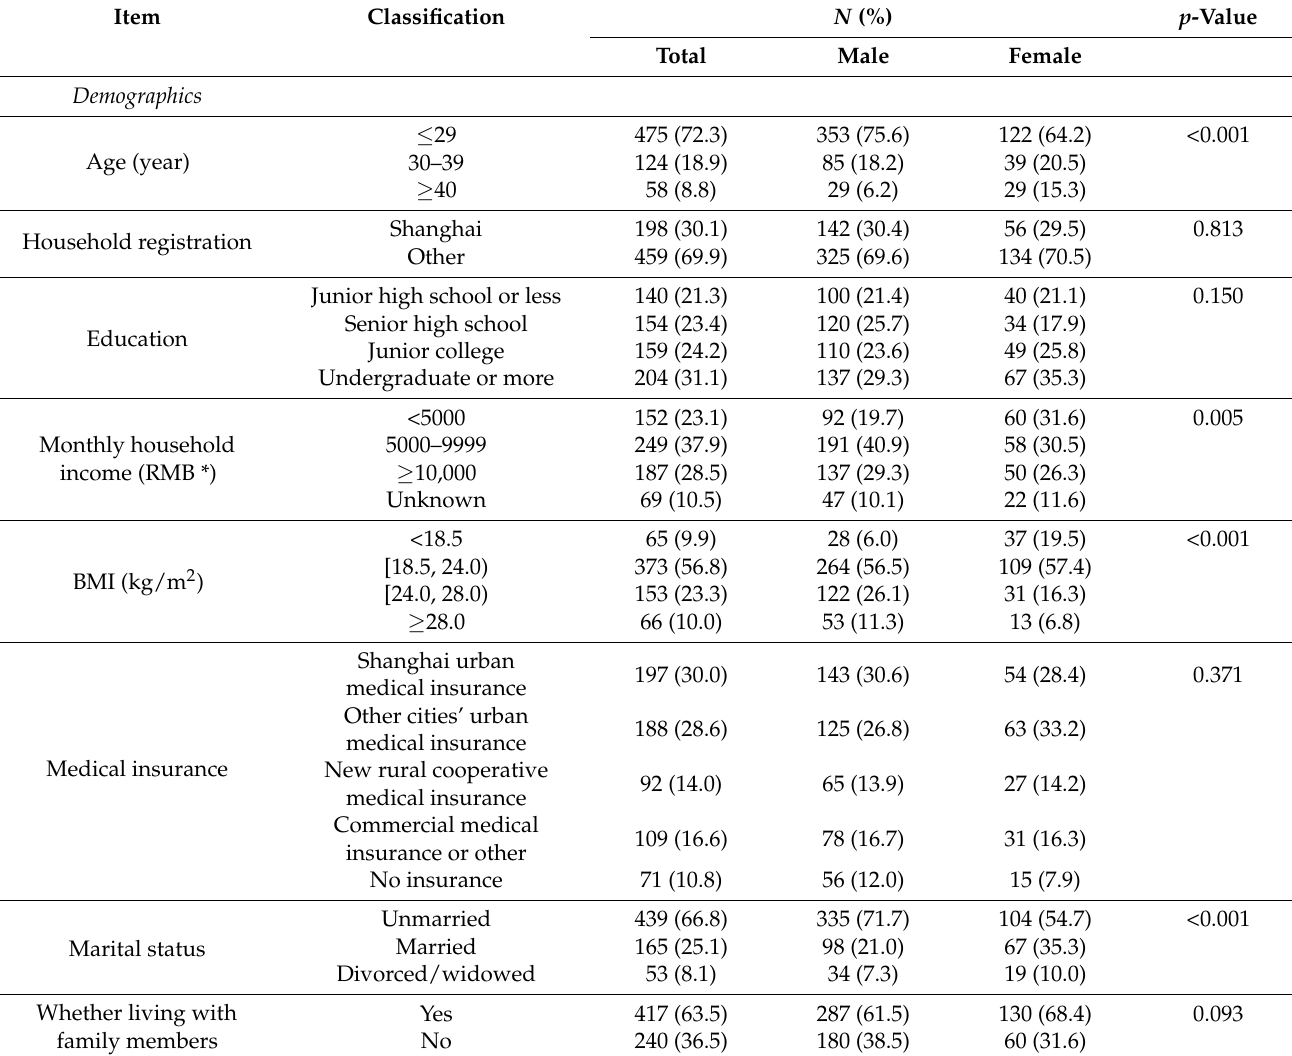
Table 1. Descriptive analysis of